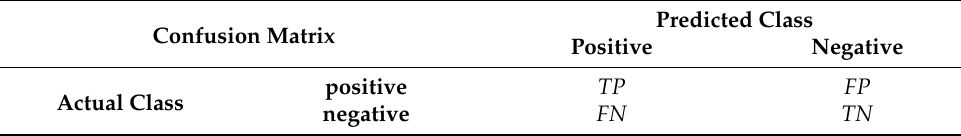
Table 4. A confusion matrix for two-class